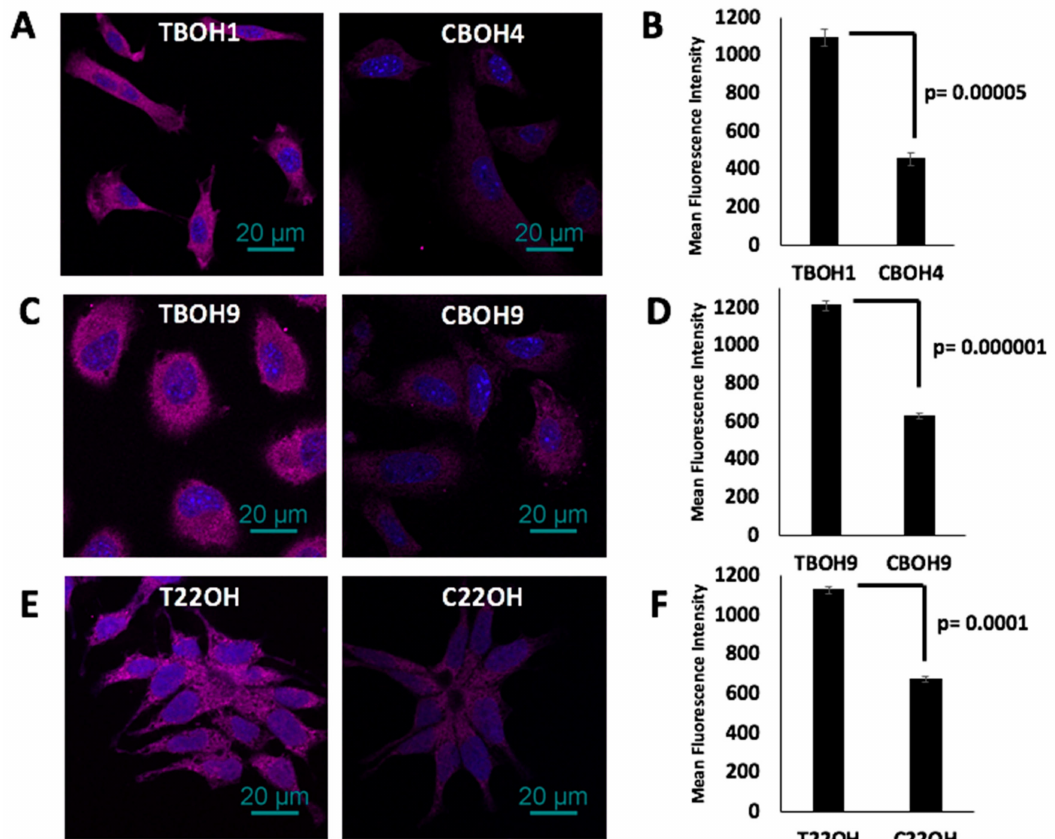
Figure 7. Decreased intracellular endostatin expression by CTCs. ( A , C , E ) Endostatin expression in TBOH1 and CBOH4, TBOH9 and CBOH9, and T22OH and C22OH was determined using immunofluorescence. ( B , D , F ) Mean fluorescence intensity was quantified using the NIS Elements software. Data are presented as mean ± standard error of the mean